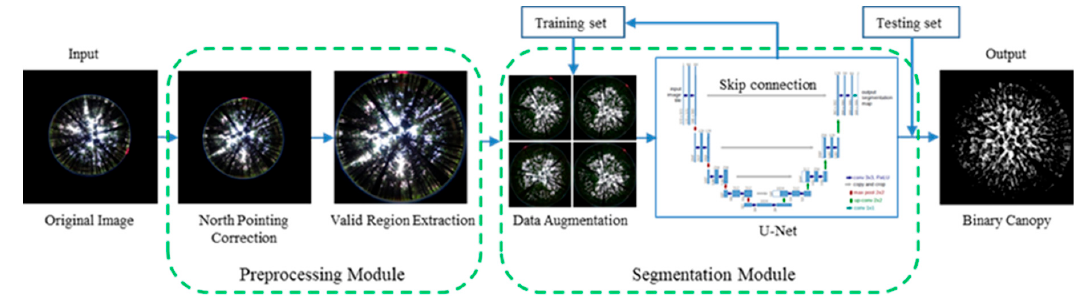
Figure 2. Overall flow chart of the canopy segmentation method.